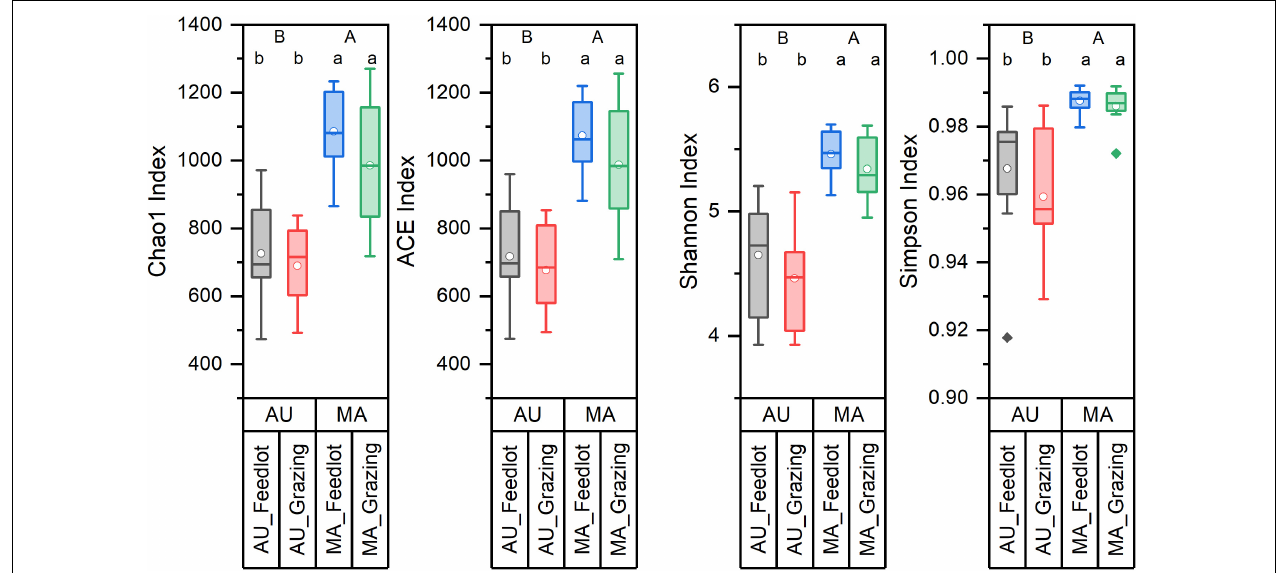
FIGURE 1 | Diversity indices of the rumen microbiota of Aubrac (AU) and Maremmana (MA) breeds in the two rearing systems (feedlot and grazing). Uppercase letters (A and B) show significant differences ( p < 0.05) between breeds. Lowercase letters (a and b) show significant differences ( p < 0.05) due to the interaction breed × rearing system. The biodiversity is lower in the bacterial communities in the rumen of AU steers.